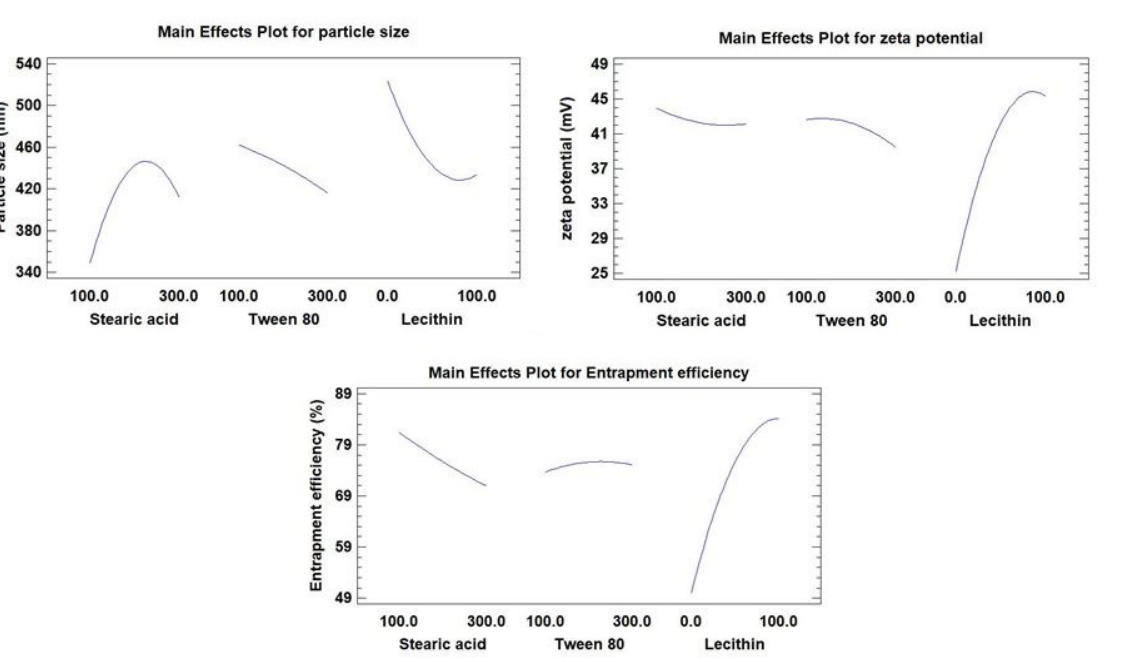
Figure 2. Standardized Pareto charts showing the effects of the investigated factors on all responses (Y